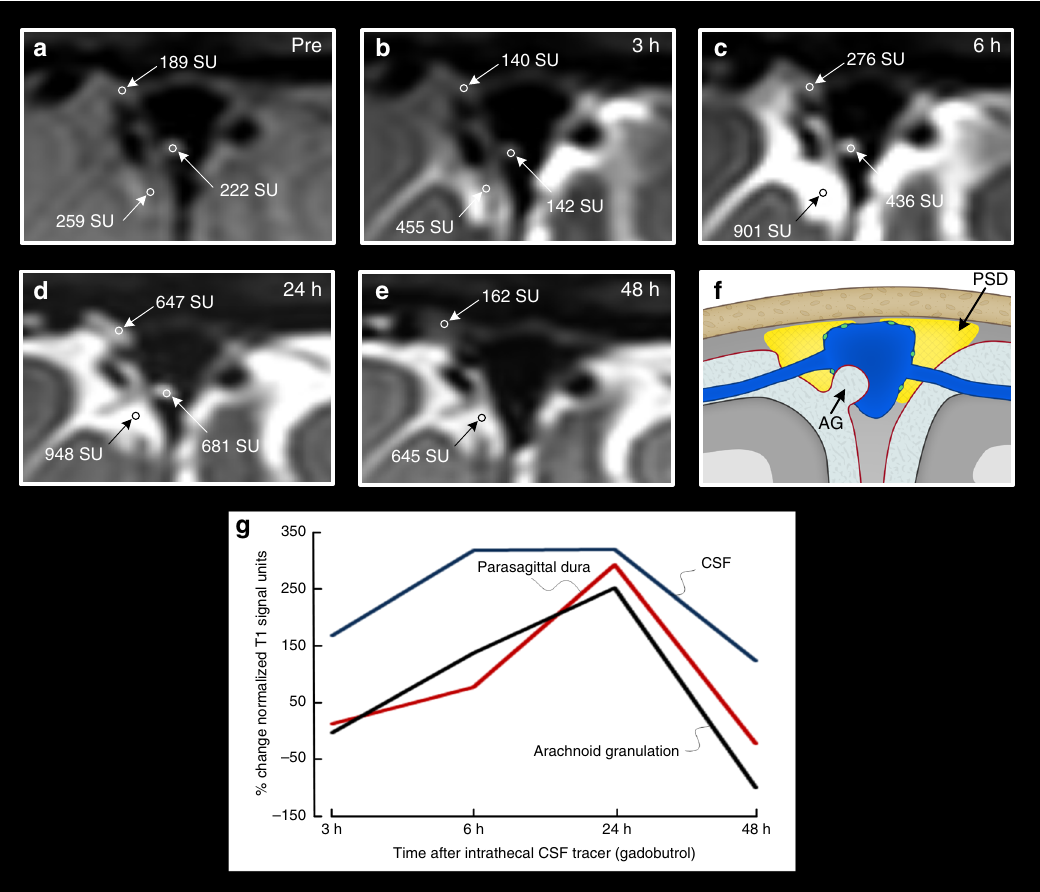
Fig. 3 Visualization of the parasagittal dura and an arachnoid granulation. The T1-BB images are shown for one individual (no. 8) prior to intrathecal gadobutrol injection ( a ), and after 3 h ( b ), 6 h ( c ) 24 h ( d ) and 48 h ( e ). The enrichment of CSF tracer is quanti fi ed as change in signal units (SU) within the parasagittal dura, CSF space and within one arachnoid granulation. The regions of interest are marked by an open circle. At 48 h ( e ), enhancement of the arachnoid granulation could no longer be detected. In f is illustrated the parasagittal dura (PSD, indicated with yellow color) and an arachnoid granulation (AG; illustration: Øystein Horgmo, University of Oslo). In g , the percentage change in normalized T1-BB signal units in CSF (blue line), PSD (red line) and arachnoid granulation (black line) in this individual is